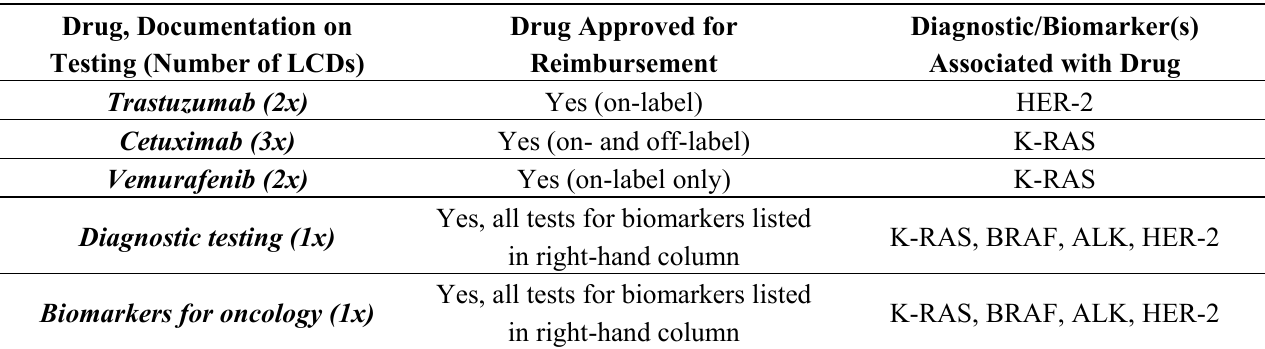
Table 4. Medicare Part B local coverage determinations